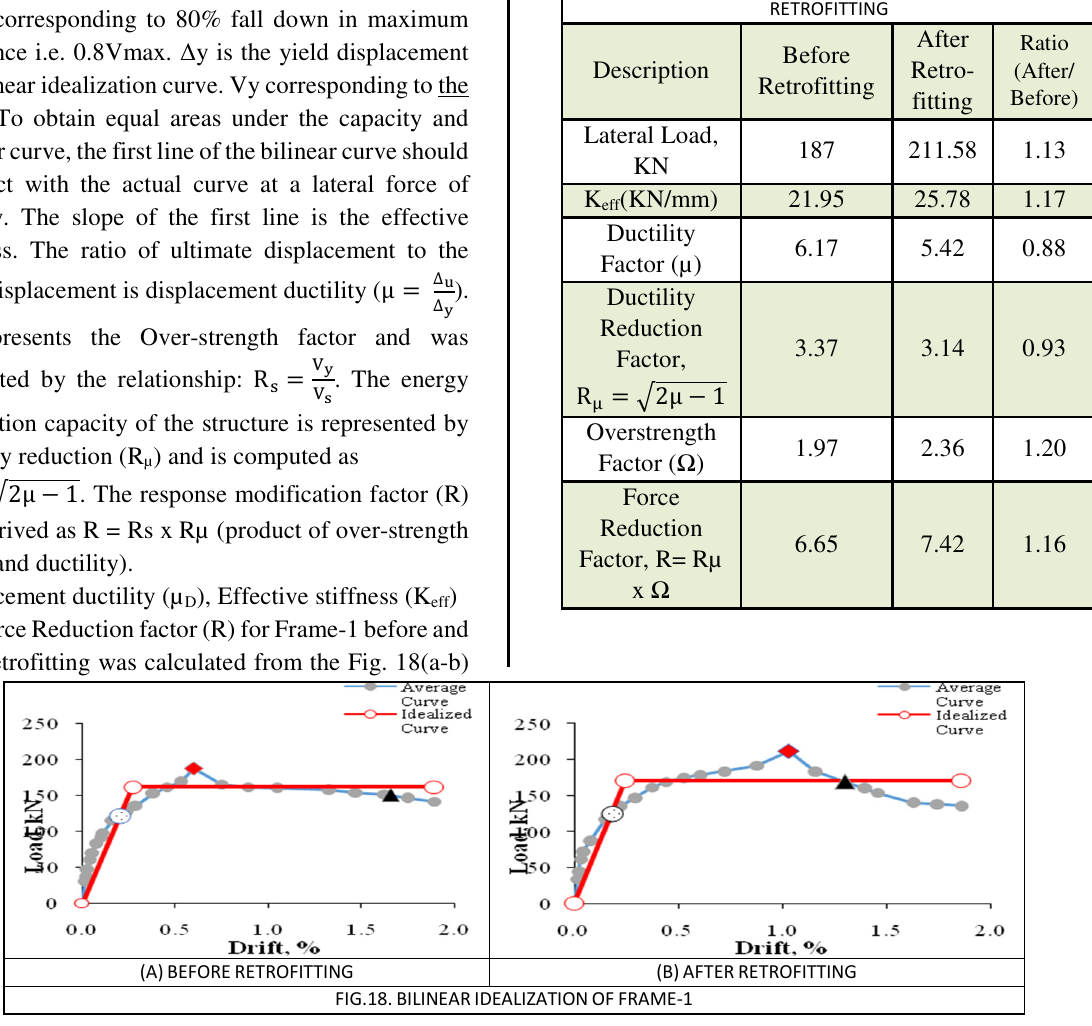
TABLE 2. FRAME-1 SEISMIC PARAMETERS BEFORE AND AFTER